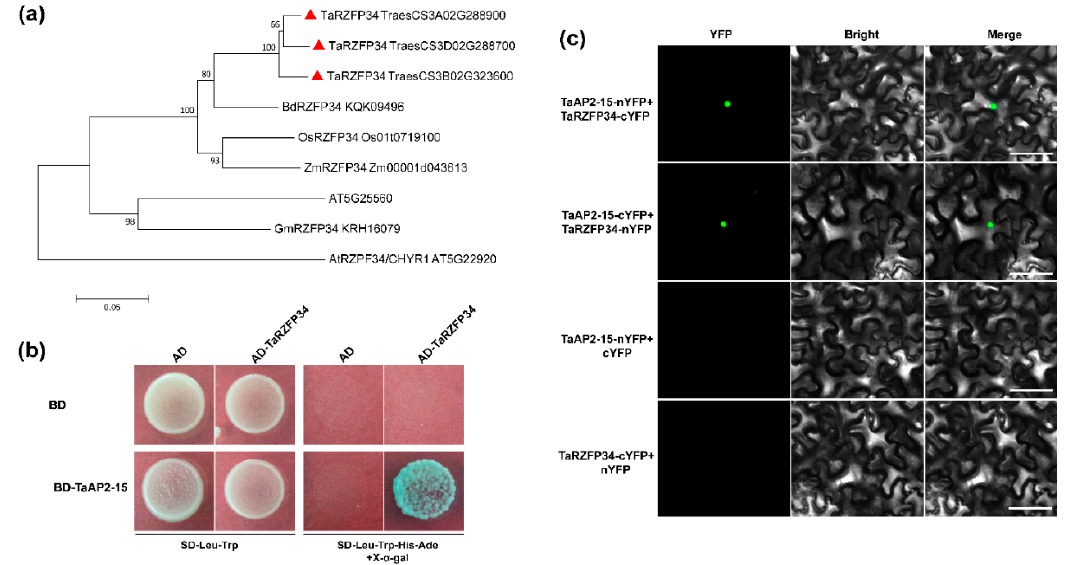
Figure 8. TaAP2-15 interacts with TaRZFP34. ( a ) Neighbor joining phylogenetic tree of TaRZFP34 with its orthologs. Bootstrap values shown at each node were estimated based on 1000 replications. Gene names and GenBank accession numbers are indicated. Ta, Triticum aestivum ; Bd, Brachypodium distachyon ; Os, Oryza sativa ; Zm , Zea mays ; Gm, Glycine max ; At, Arabdopsis thaliana . The red triangle indicates three RZFP34 homologs in wheat. ( b ) TaAP2-15 interacts with TaRZFP34 verified by yeast two-hybrid. Constructs (pBD-TaAP2-15 and pAD-TaRZFP34) were plated on selective media SD-W/-L or SDW/-L/-H/-A (SD/-Trp/-Leu or SD/-Trp/- Leu/-His/-Ade containing 20 μ g /mL X- α -gal). SD, synthetic dropout growth medium. ( c ) TaAP2-15 interacts with TaRZFP34 in planta . The constructs, TaAP2-15-nYFP+TaRZFP34-cYFP; TaAP2-15-cYFP+TaRZFP34-nYFP; TaAP2-15-nYFP+cYFP and TaRZFP34-cYFP+nYFP, were agroinfiltrated in to N. benthamiana leaves. After two or three days, samples from the infiltrated leaves were examined for fluorescent signals under a microscope. Bar, 100 μ m.